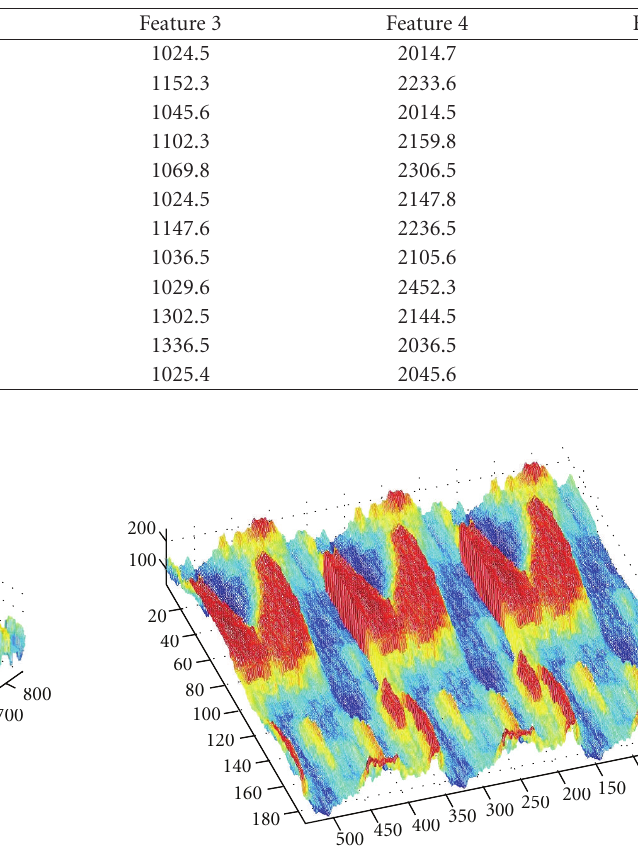
Figure 11: The constructed turbulence kinetic energy distribution surface of energy optimization modeling in high-pressure reversing valve runner. Table 5: Energy distribution surface features in B-spline quasiuniform bicubic.